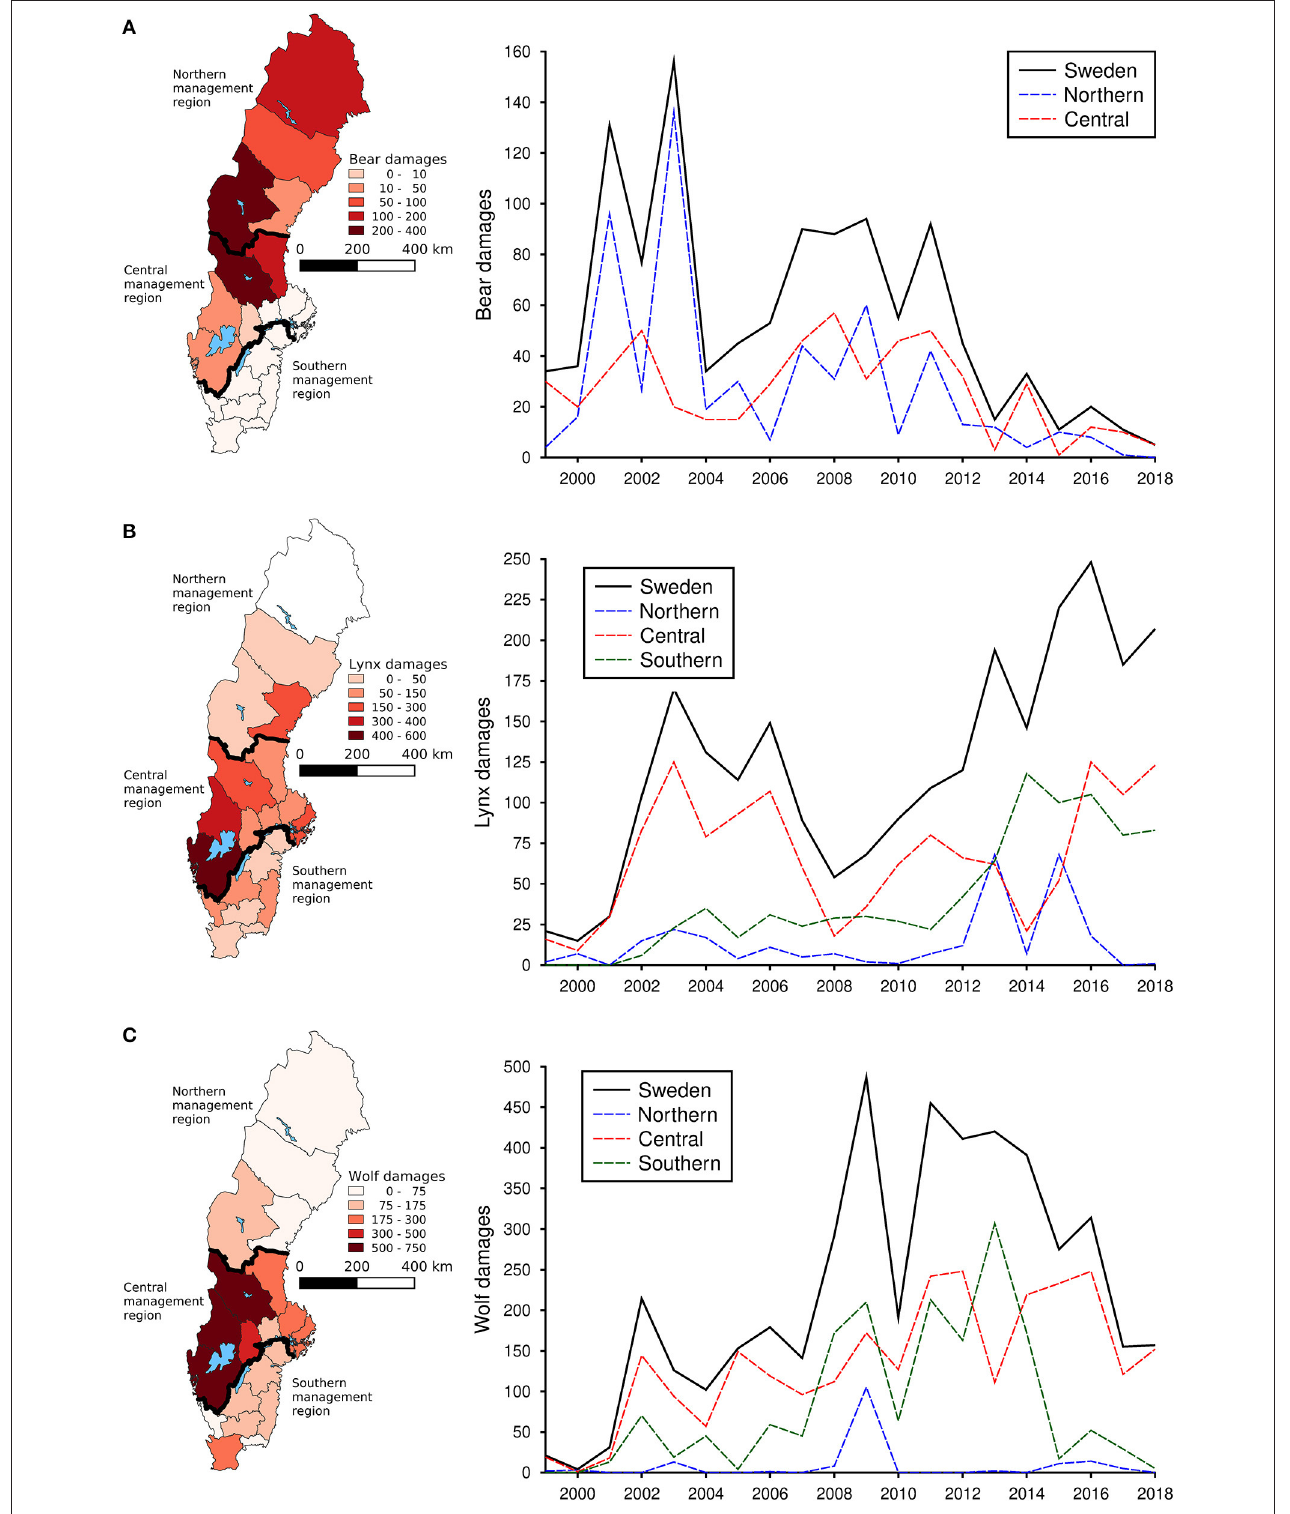
FIGURE 3 | Total number of damaged sheep by brown bear (A) , Eurasian lynx (B) , and gray wolf (C) in each county of Sweden from 1999 to 2018 as well as the national and regional trends for the same time period.